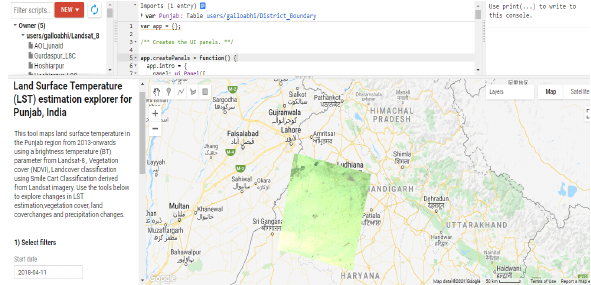
Figure 9: GEE Explorer Web-App for LST